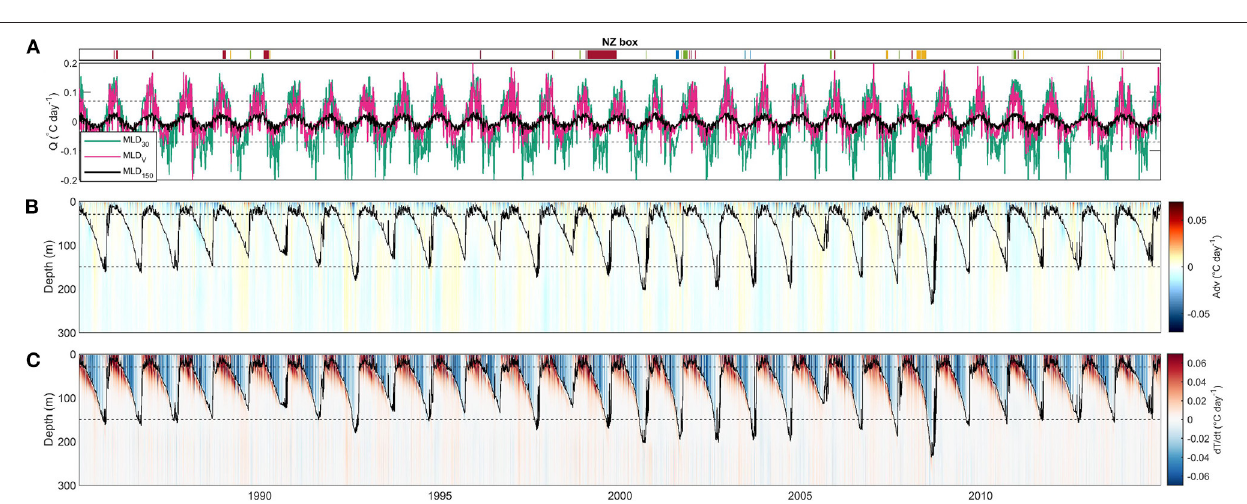
FIGURE 10 | NZ box time-series (1985–2014) showing the air-sea heatflux term (A) as calculated using the three SML scenarios: MLD 30 (green), MLD V (red), and MLD 150 (black). Hovmoller plots shows advection contribution (B) and temporal change of temperature (C) with depth. MLD V is shown with a solid black line, MLD 30 and MLD 150 are marked by dashed lines. MHWs are marked with rectangles in the top bar with colors corresponding to the season in which an event began: summer (DJF) = red, autumn (MAM) = yellow, winter (JJA) = blue, spring (SON) =